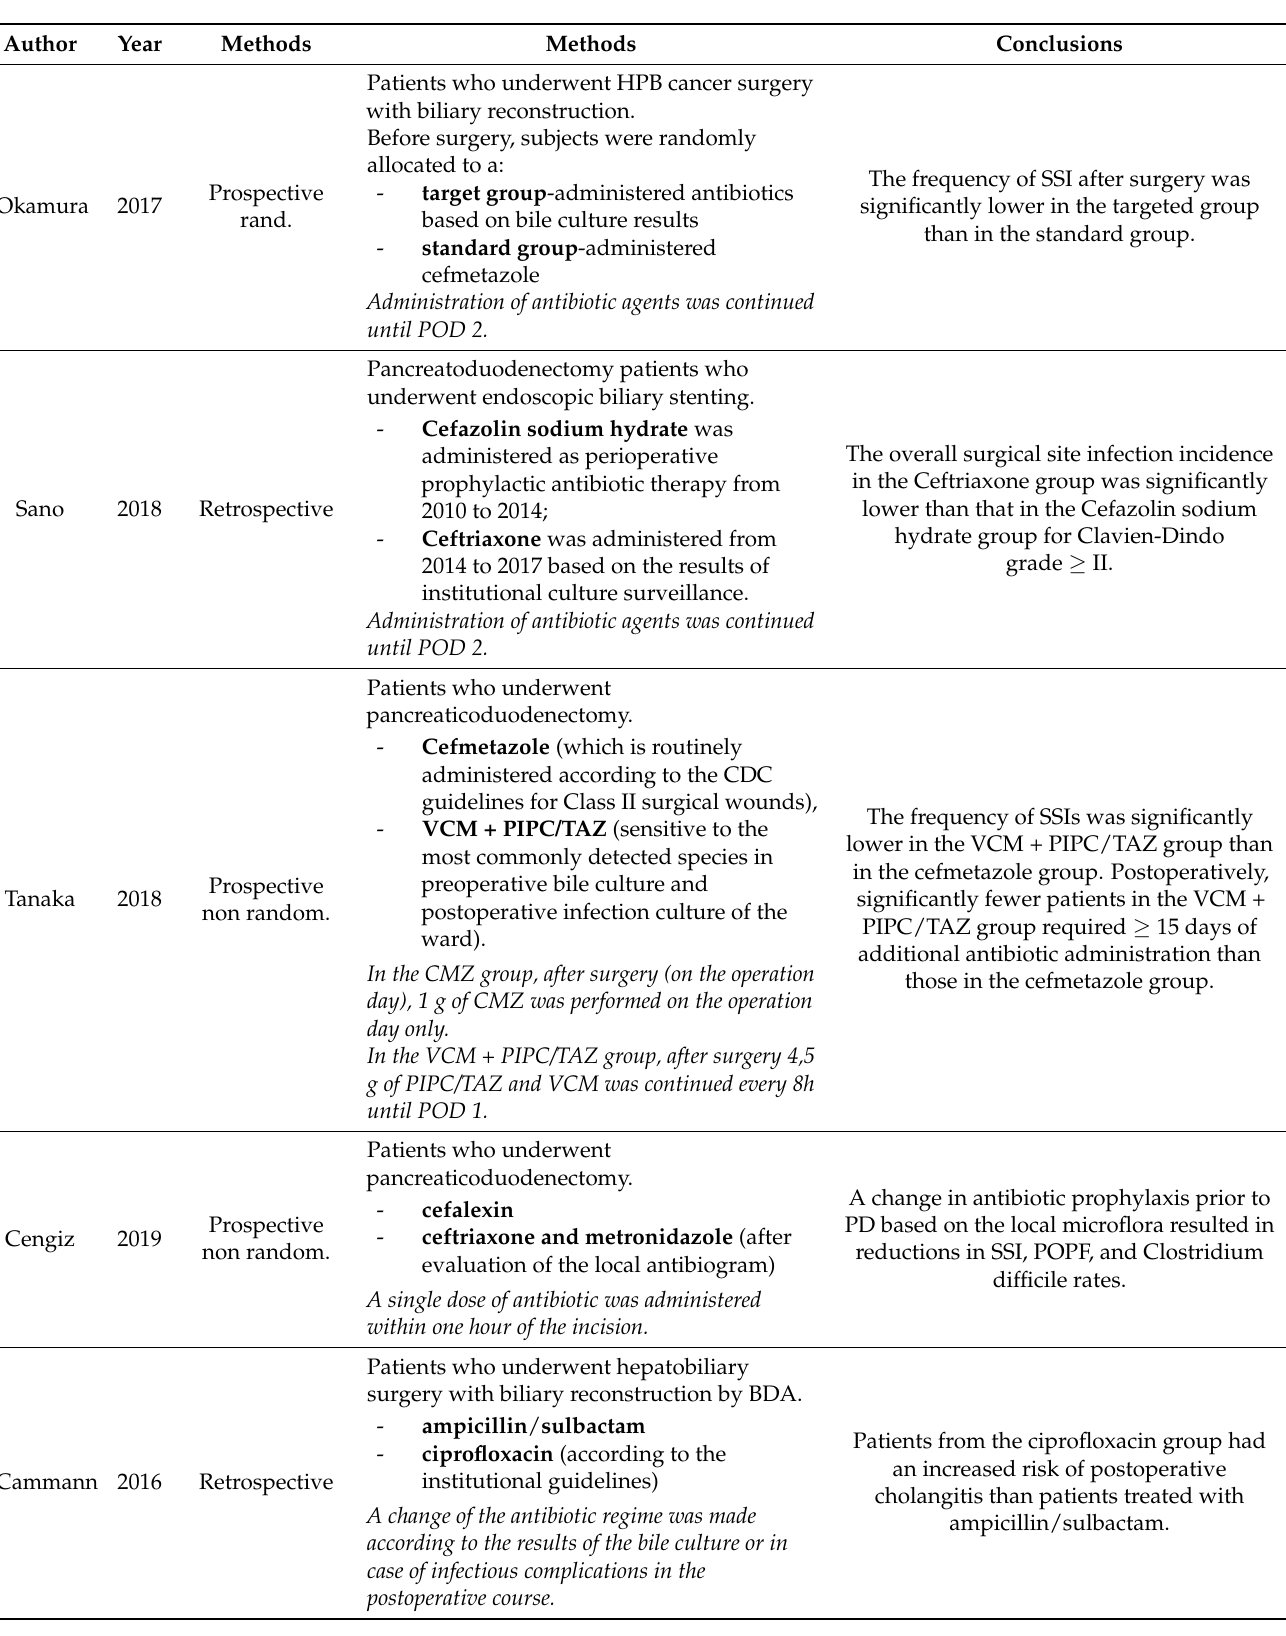
Table 1. Patients underwent HBP